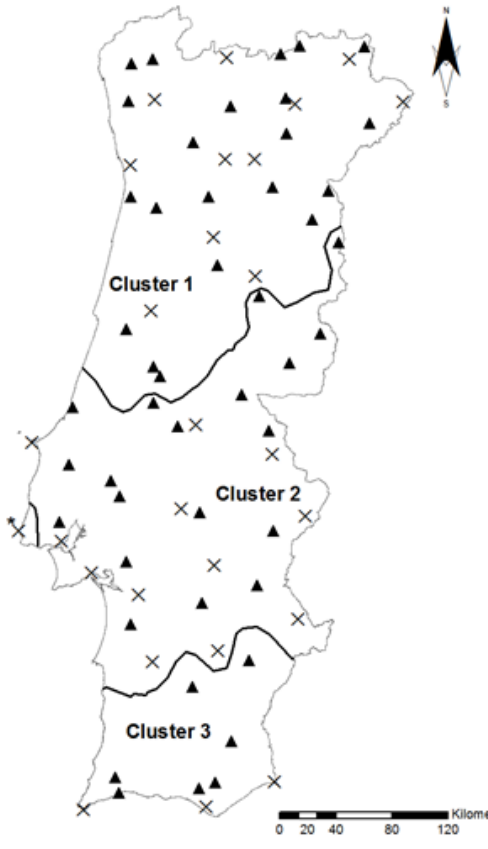
Figure 1. Spatial distribution of the meteorological stations ( × ) and rainfall stations ( (cid:78) ) used in the study and delimitation of drought clusters; (* station included in cluster